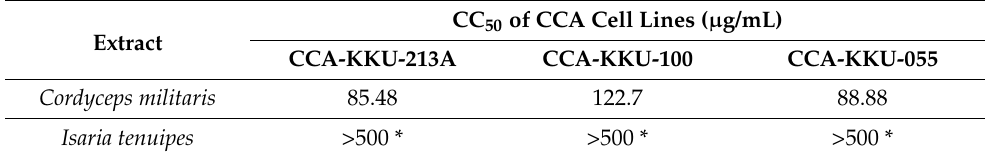
Table 2. Cytotoxicity of the C. militaris and I. tenuipes extracts on CCA cell lines.